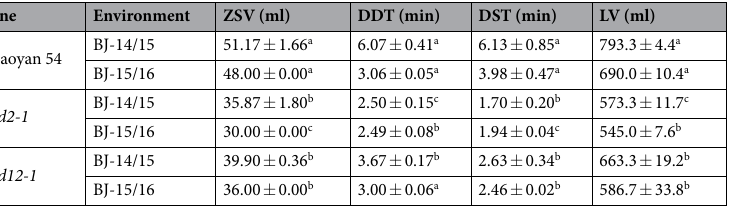
Table 5. Comparison of gluten, dough and breadmaking parameters among Xiaoyan 54, md2-1 and md12-1 cultivated in two crop cycles (2014/2015 and 2015/2016) a . a Each value is the mean ± SE of three separate tests. Different letters after the means indicate statistically significant difference ( P < 0.05). BJ, Beijing; DDT,